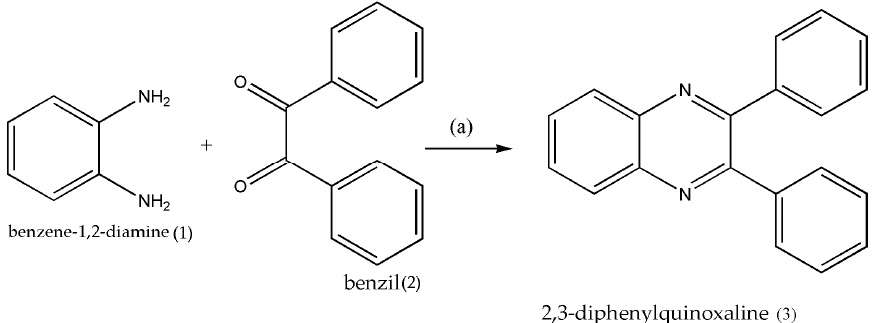
Table 1. The condensation of benzene-1,2-diamine (1 mmol) with benzyl (1 mmol) in the presence of various quantities of bentonite clay K-10 in ethanol (20 mL) at room temperature.